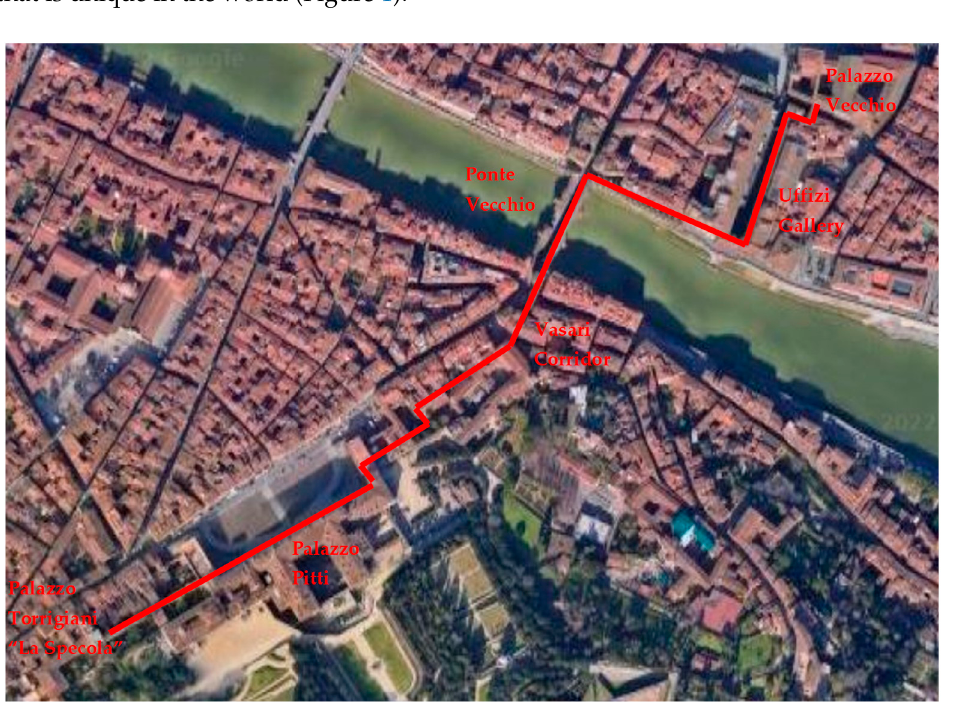
Figure 1. View of the path that connects Palazzo Vecchio with Palazzo